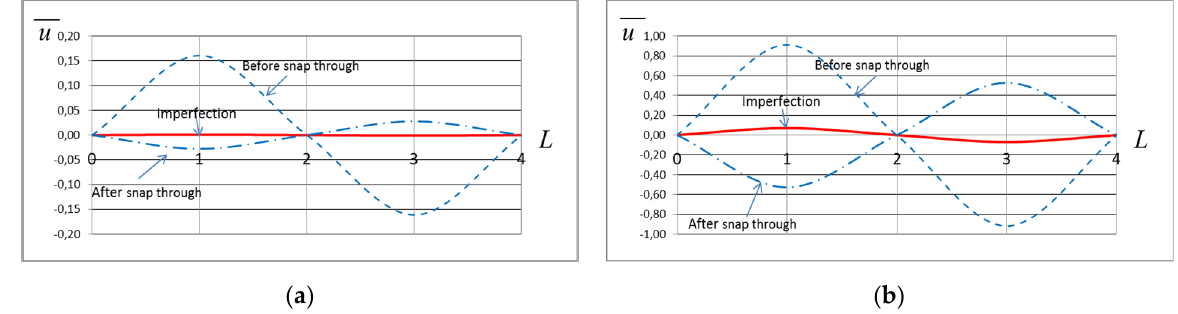
Figure 11. Configuration of displacement before and after snap-through for initial amplitudes of geometrical imperfections developed according to the second buckling mode: ( a ) small ( m 2), ( b ) large ( d 2).